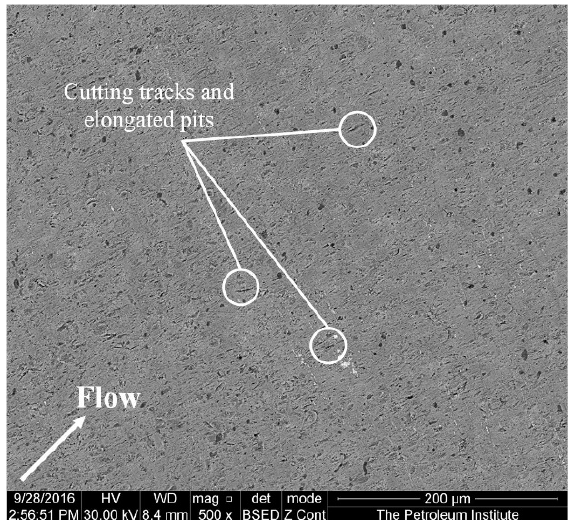
Figure 7. Surface of the specimen 3 mm away from the center after 4 h of testing at 20 m/s and 600 mg/L .